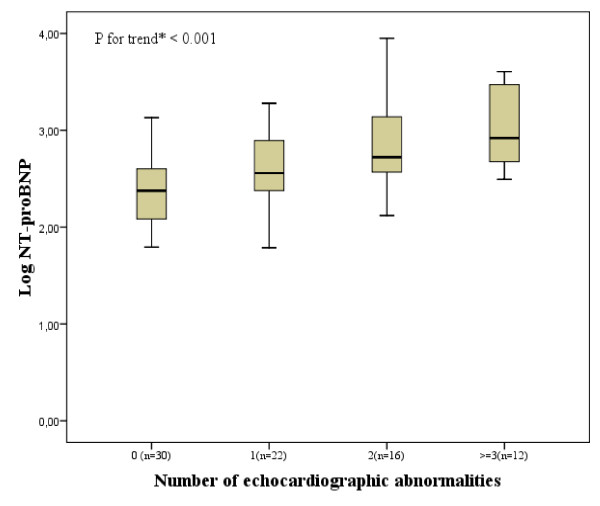
Relationship between LogNT-proBNP Level and Number of Cardiac Abnormalities at Age 90. Error bars in these box-and-whisker plots show the mean and 95% confidence intervals of LogNT-proBNP at age 90 related to total amount of cardiac abnormalities, including LVEDD > 33 mm/m2, EF < 50%, indexed left atrial volume >40 ml/m2, LV hypertrophy (men > 149 g/m2, women > 122 g/m2), presence of severe mitral regurgitation, presence of severe aortic regurgitation, presence of severe aortic stenosis or PAP ≥ 40 mmHg. * by ANOVA.